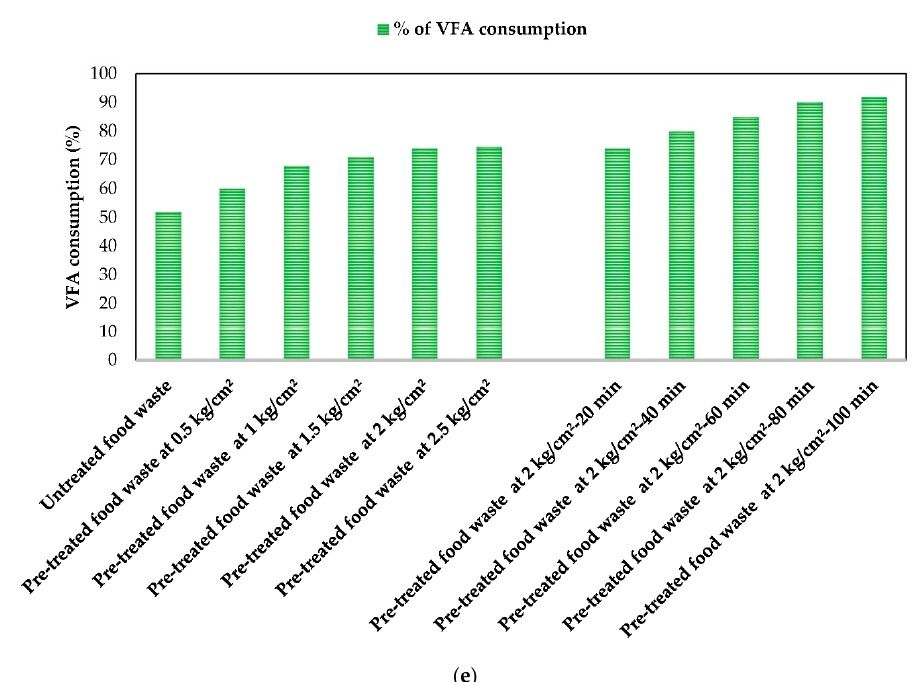
Figure 6. Volatile fatty acids (VFA) generation, VFA consumption and pH profile for pretreated food waste at different pressures and time durations. ( a ) VFA profile for pretreated food waste experiments at differ pressures; ( b ) pH profile for pretreated food waste experiments at different pressures; ( c ) VFA profile for pretreatment of food waste experiments at different time intervals; ( d ) pH profile for pretreated food waste experiments at different time intervals; ( e ) VFA consumption profile of pretreated food waste at different pressure.